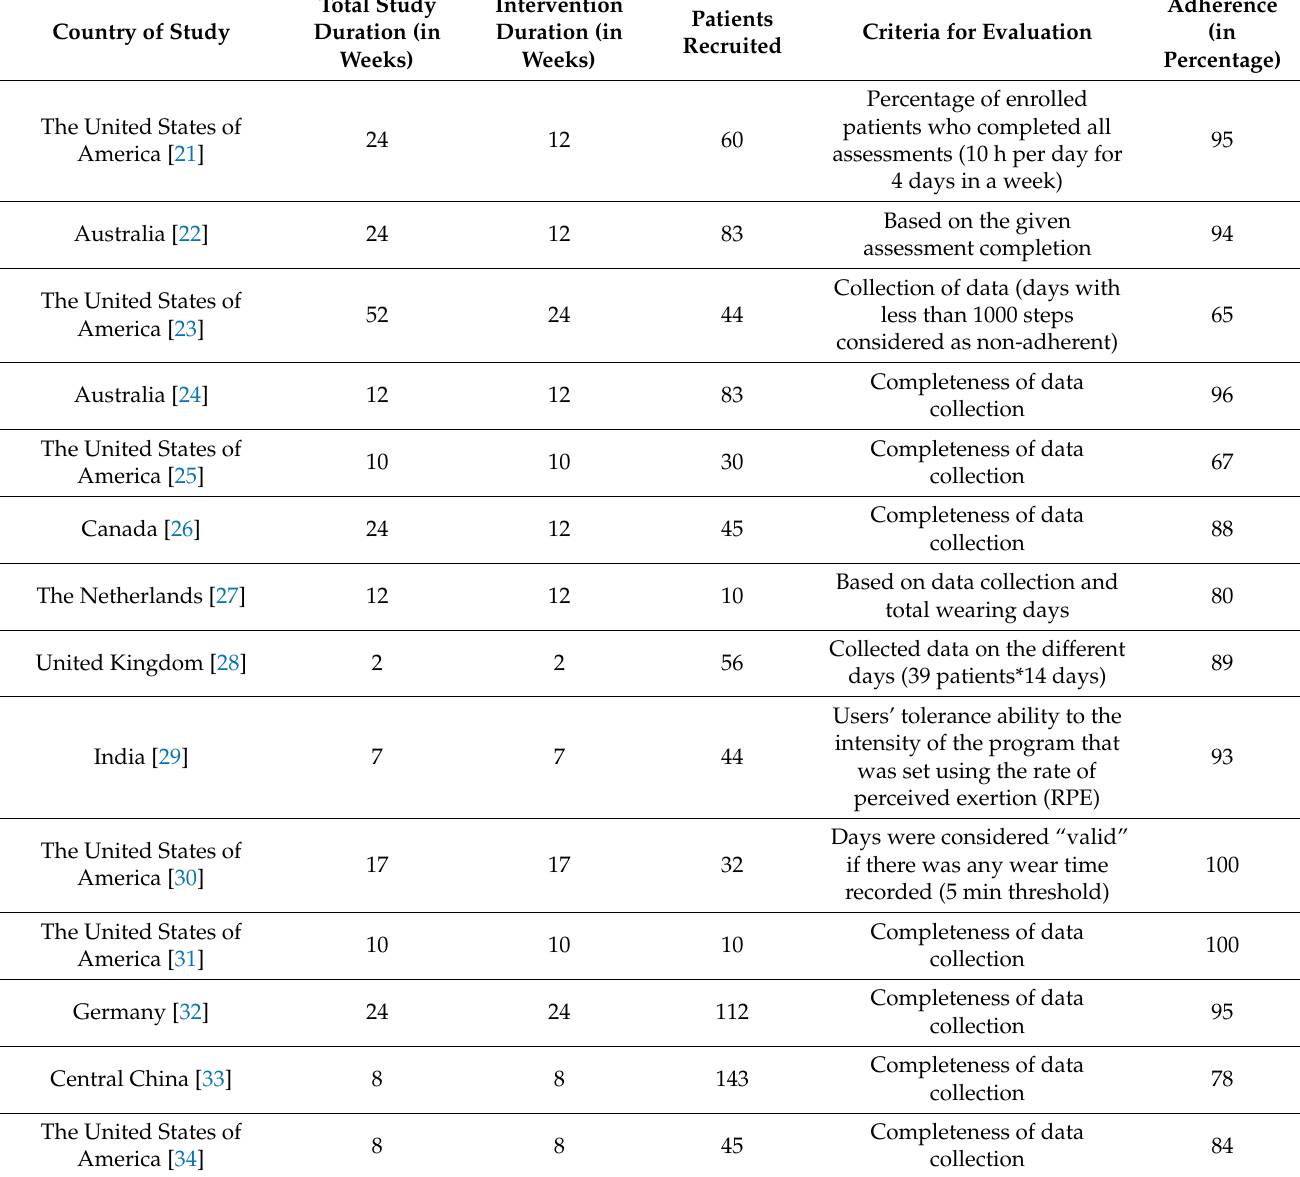
Table 2. Adherence to wearable devices in the cancer